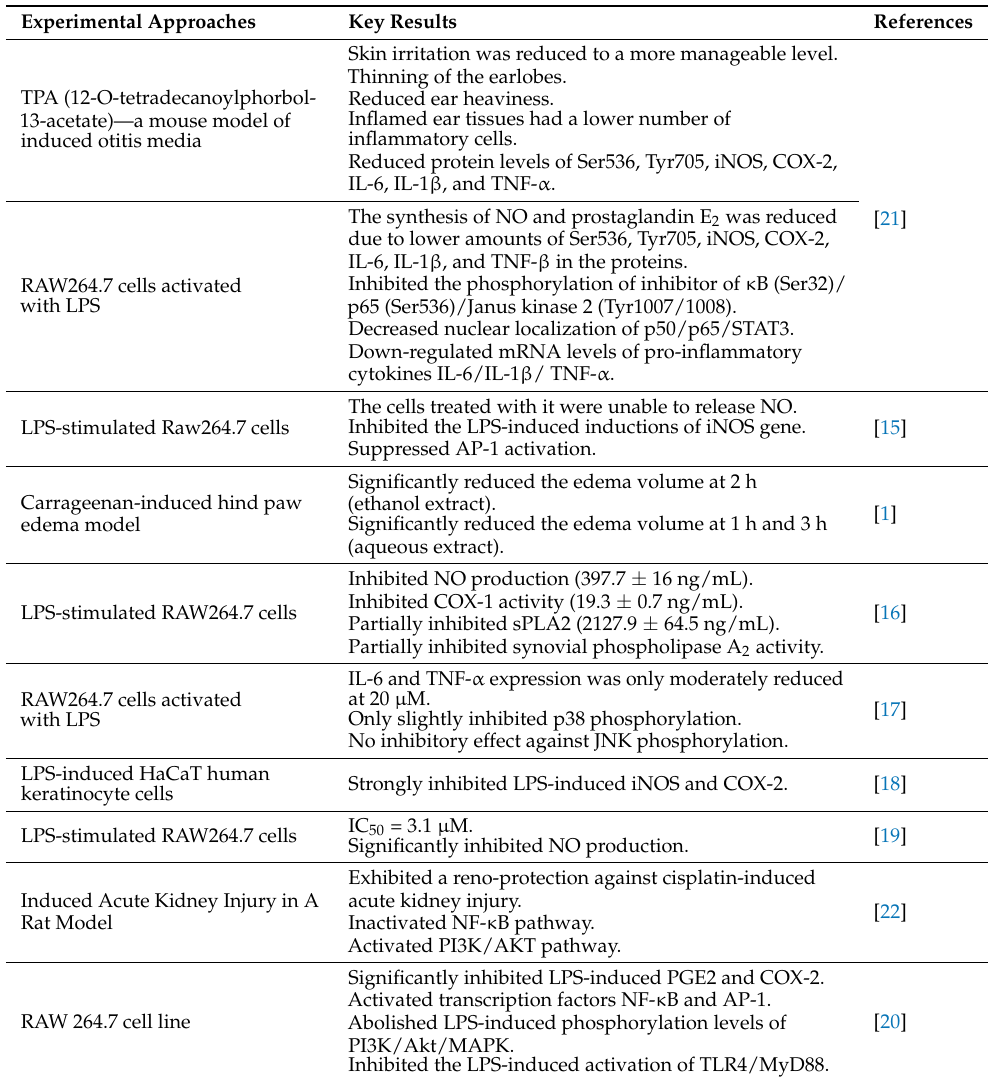
Table 3. Anti-inflammatory